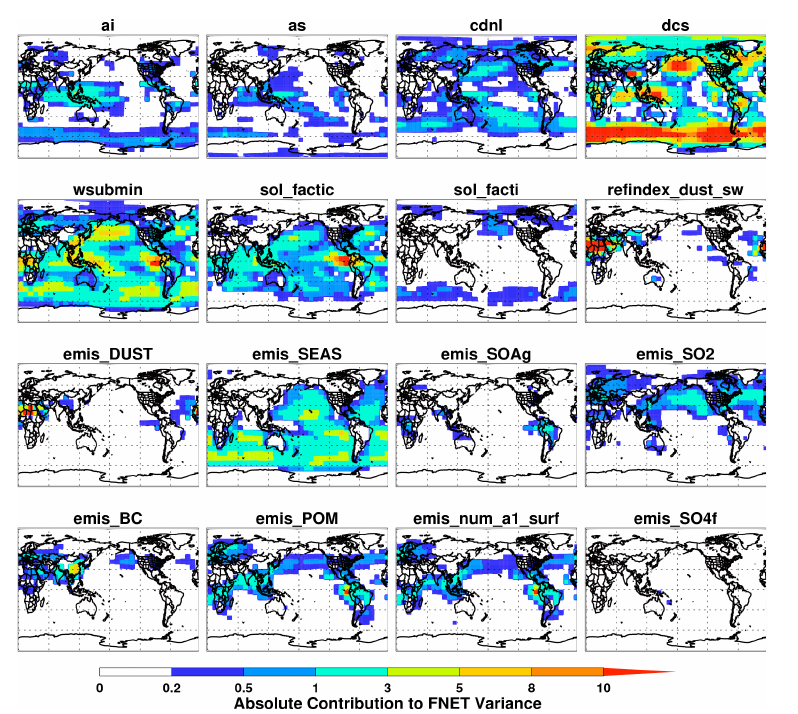
Figure 8 Global spatial distribution of absolute FNET variance (unit in W 2 /m 4 ) in 1089 Fig. 8. Global spatial distribution of absolute FNET variance (unit in W 2 m − 4 ) in response to the perturbation of each of the 16 input parameters predicted by the